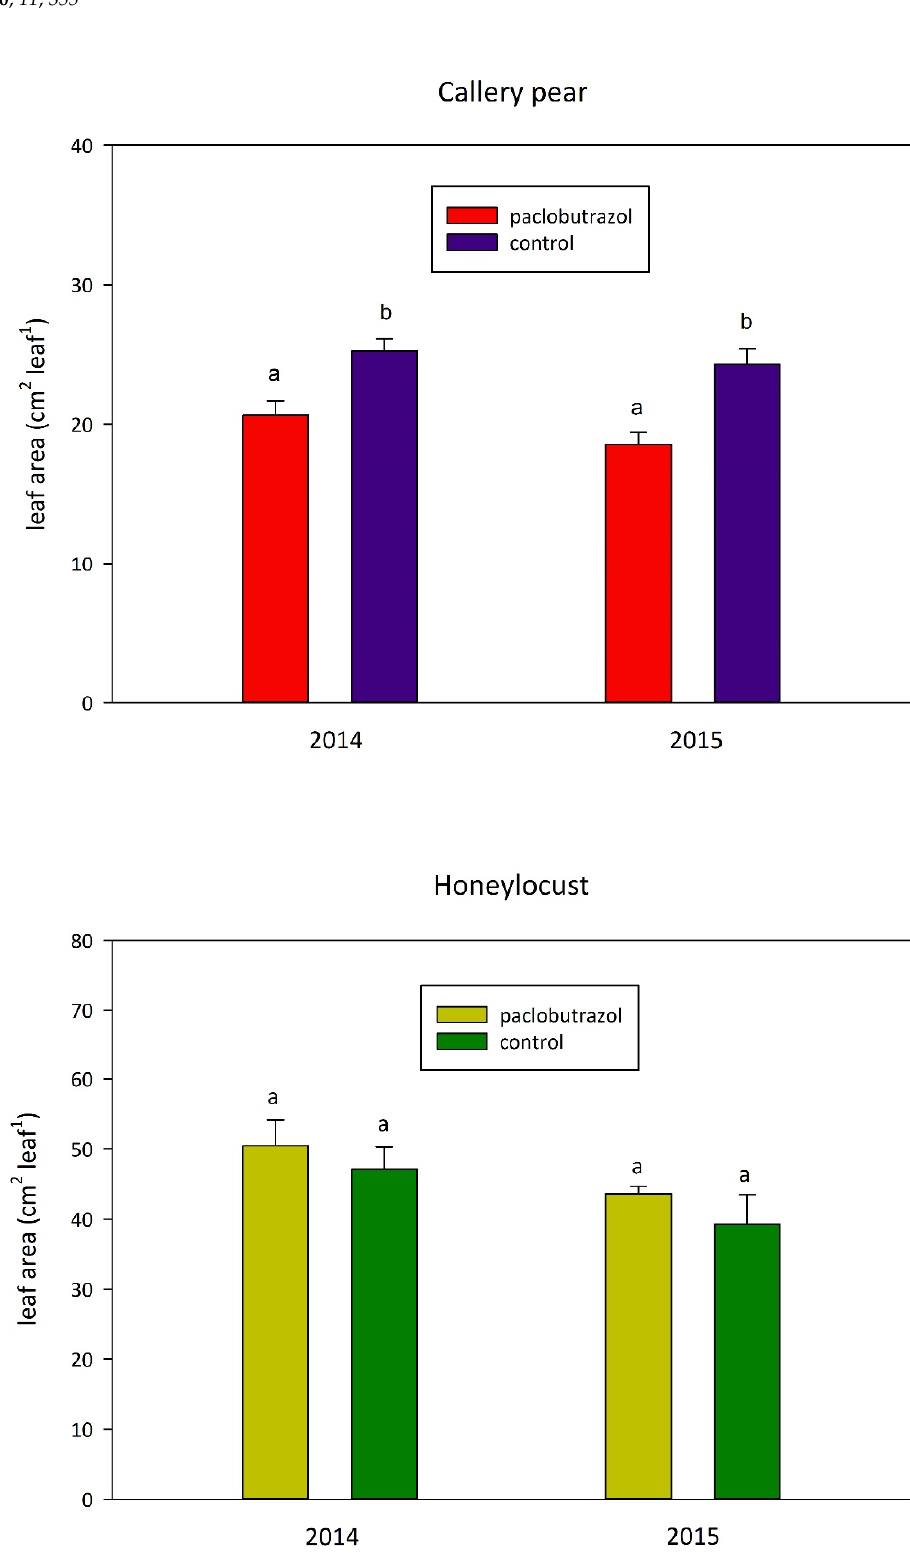
Figure 4. Mean leaf size of leaves of Callery pear (top) and honeylocust (bottom) trees in Lansing, MI USA in 2014 and 2015. Trees were treated with paclobutrazol in 2013 (paclobutrazol) or not treated (control). Error bars indicate standard error of the mean. Means within a species and year indicated by the same letter are not different at p = 0.05.